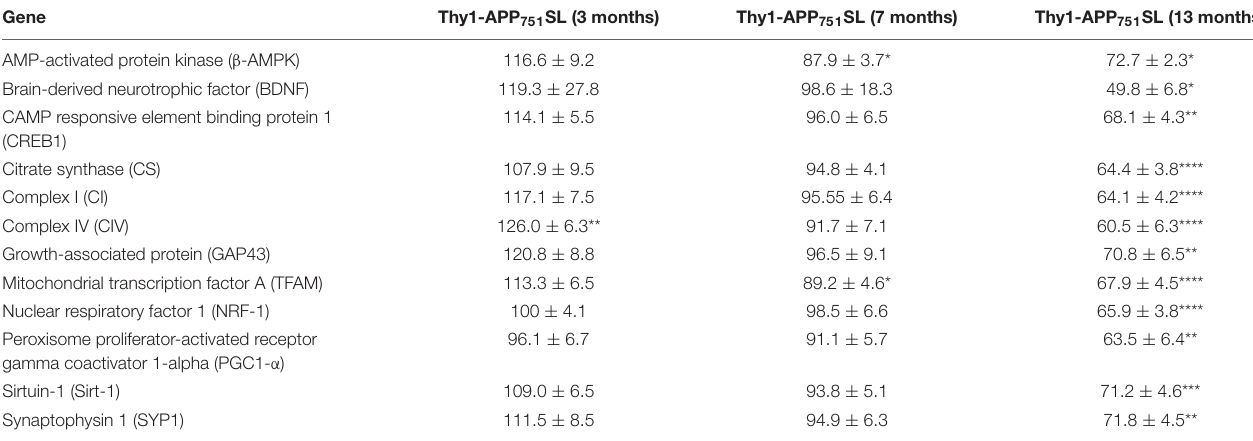
IV drops significantly at the age 13 months in Thy1-APP 751 SL ( Table 3 ). Results of mRNA expression patterns of wild-type mice during aging are shown in the